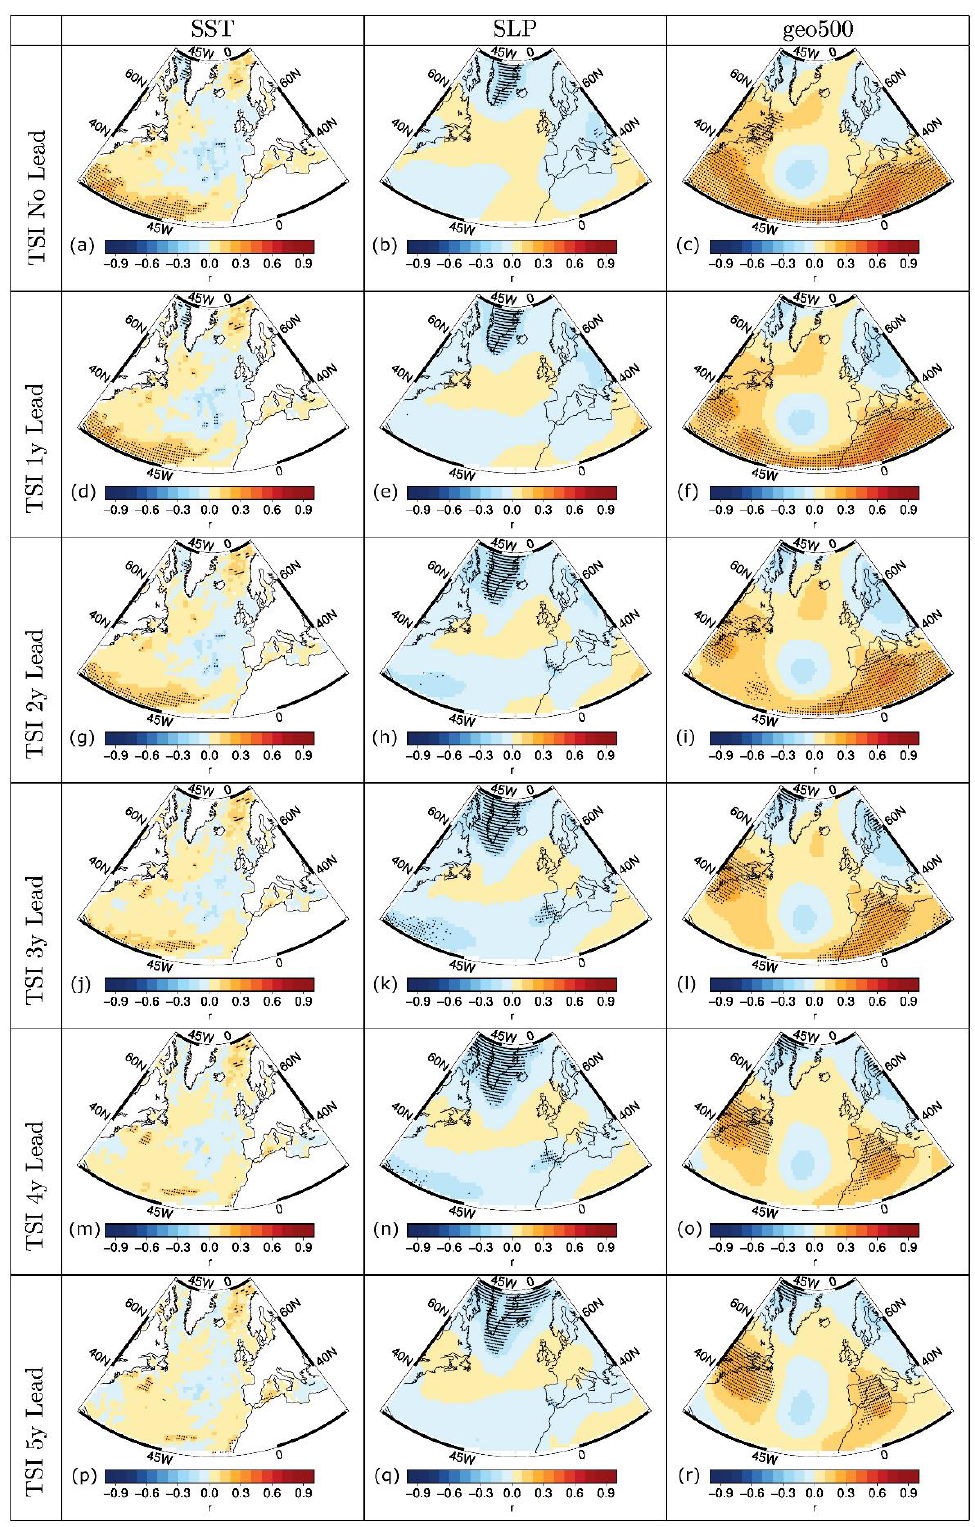
Figure 4. Correlation patterns between TSI and the SST ( a , d , g , j , m , p ), the SLP ( b , e , h , k , n , q ) and the geo500 ( c , f , i , l , o , r ) for the MPI-ESM-P. The correlation is given in the first row for no lead-time. As the row number increases, the TSI lead time increases by one year. The hatched areas indicate statistical significance at the 5% level. The range of r-values for SSTs, SLP and geo500 is approximately ±0.3, ±0.2, and ±0.4, respectively.